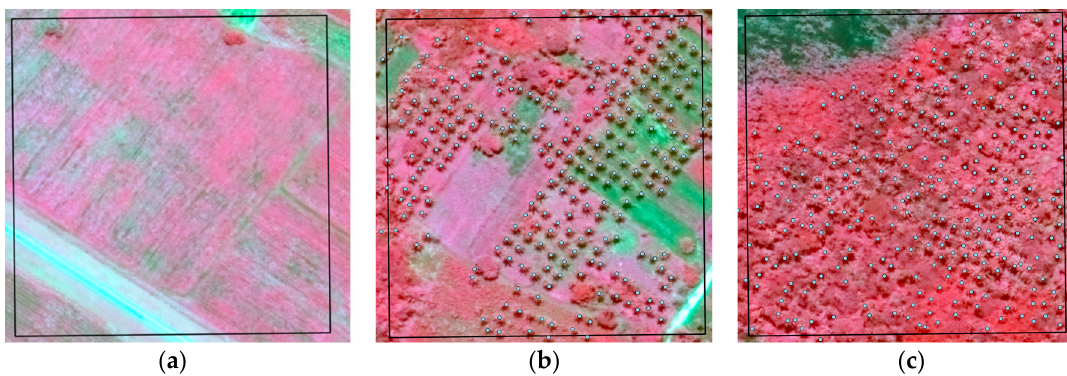
Figure 6. An example of a validation segment without any coconut trees ( a ), with the coconut tree plantation ( b ), with a mixture of coconut trees with the forest ( c ).